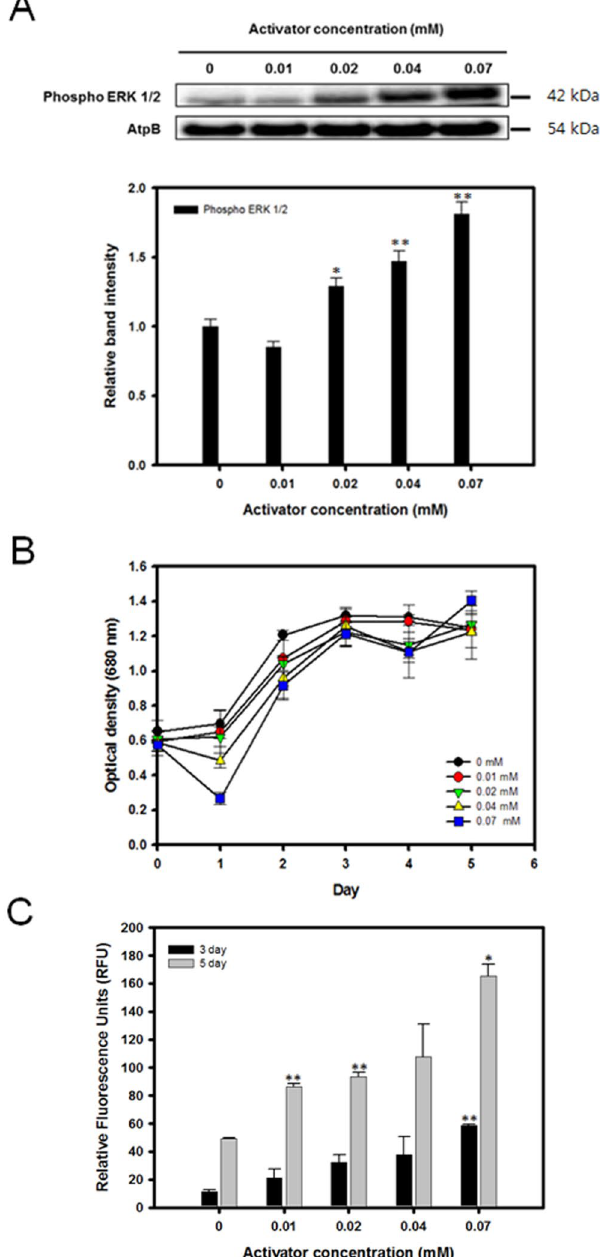
Figure 4. Expression level of ERK, cell growth profile, and lipid accumulation of C . reinhardtii grown in media containing 0.1 M NaCl with various concentrations of the ERK activator C6 ceramide. ( A ) Western blot analysis against anti-ERK1/2. ATP β antibody was detected as a loading control. Full-length blots are presented in Supplementary Fig. S6. ( B ) Cell growth (O.D. 680 nm). ( C ) Nile red fluorescence measurement at 3 and 5 days after osmotic stress induction. Data are represented as mean ± SD ( n = 3). Significant differences were determined by Student’s t-test and indicated by asterisks ( * P < 0.05, ** P < 0.01, *** P <